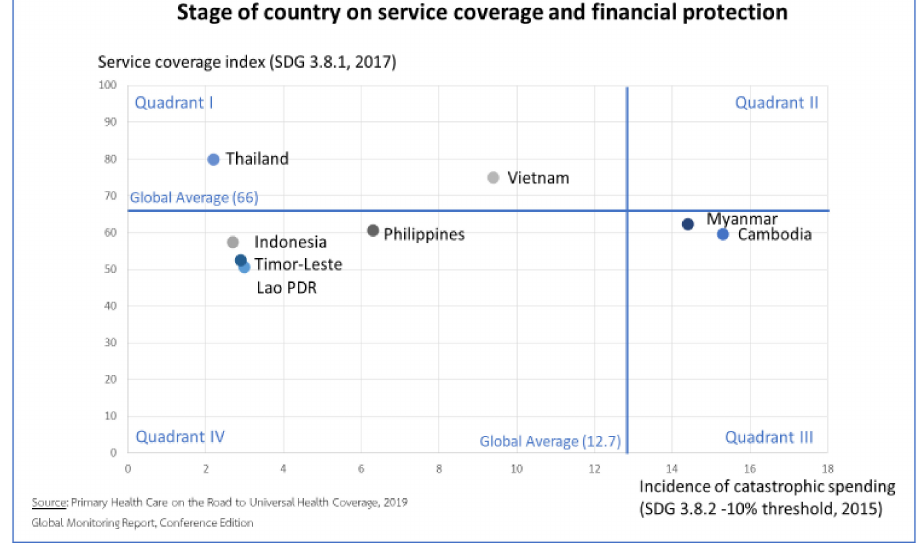
Figure 6. Stage of country on service coverage and financial protection. Data source: Primary Health Care on the Road to Universal Health Coverage, 2019: Global Monitoring Report, Conference Edition